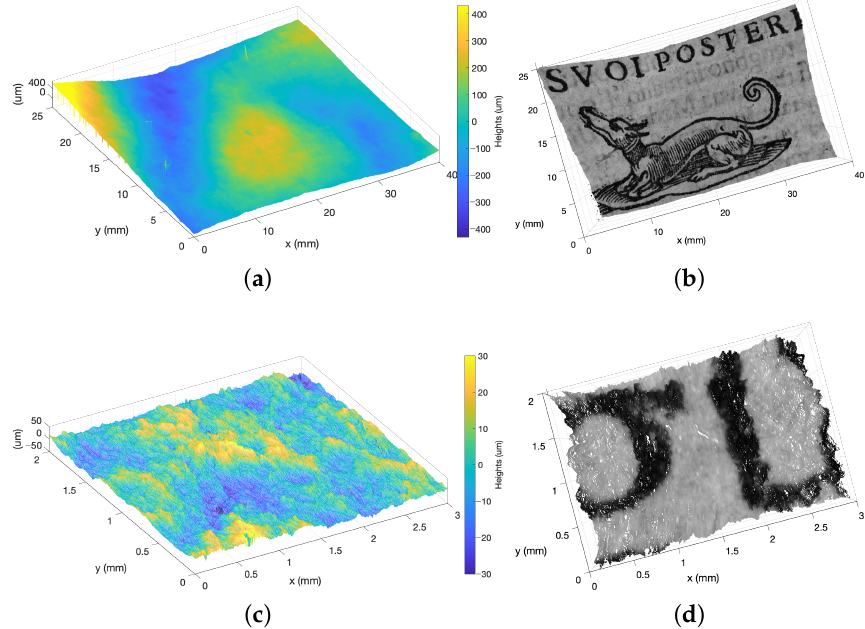
Figure 6. Combining intensity-height datasets from profilometer in book heritage acquisition. ( a , c ) Height maps. ( b , d ) Total values mapped on the point cloud obtained from the height data. Profilometer setup: (Top) ConoPoint HD, 50mm lens, 10µm scan step. (Bottom) 25 mm lens, 5µm scan step. Scan velocity